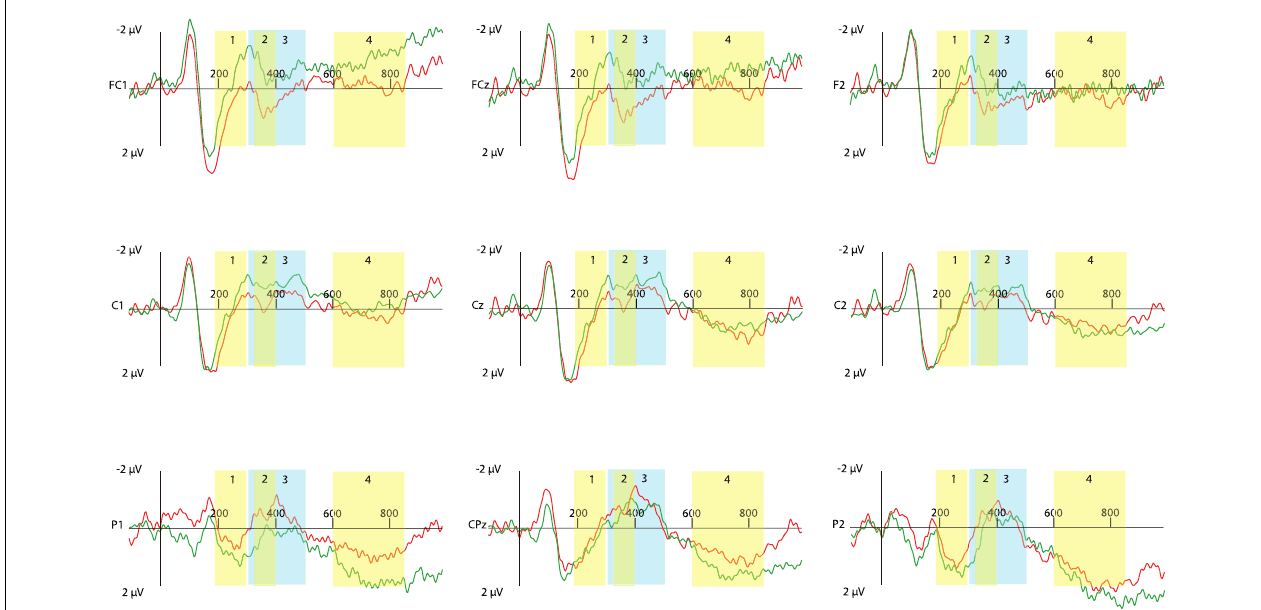
True-Mismatched condition, the green line shows theTrue-Matched condition. The limits of each of the four time windows for analysis are indicated (1 = 190–300ms; 2 = 325–400ms; 3 = 300–500ms; 4 =